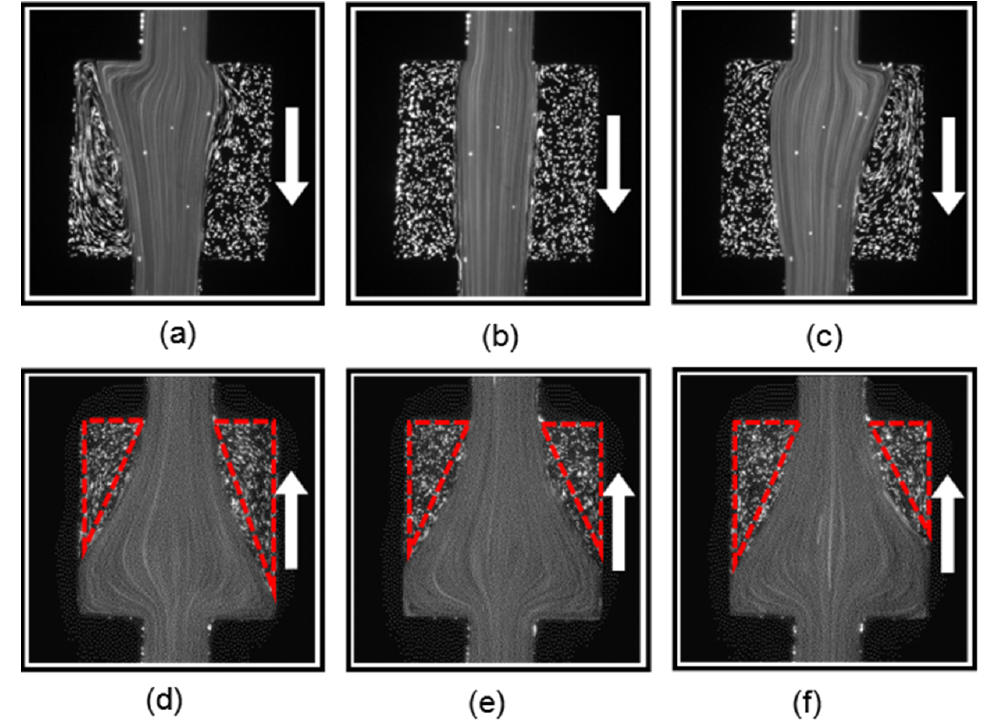
Figure 7. Viscoelastic flow pattern in the square chamber for ( a – c ) flows along the forward direction at three different instants, and ( d – f ) flows along the backward direction at three different instants at Wi = 111.11.